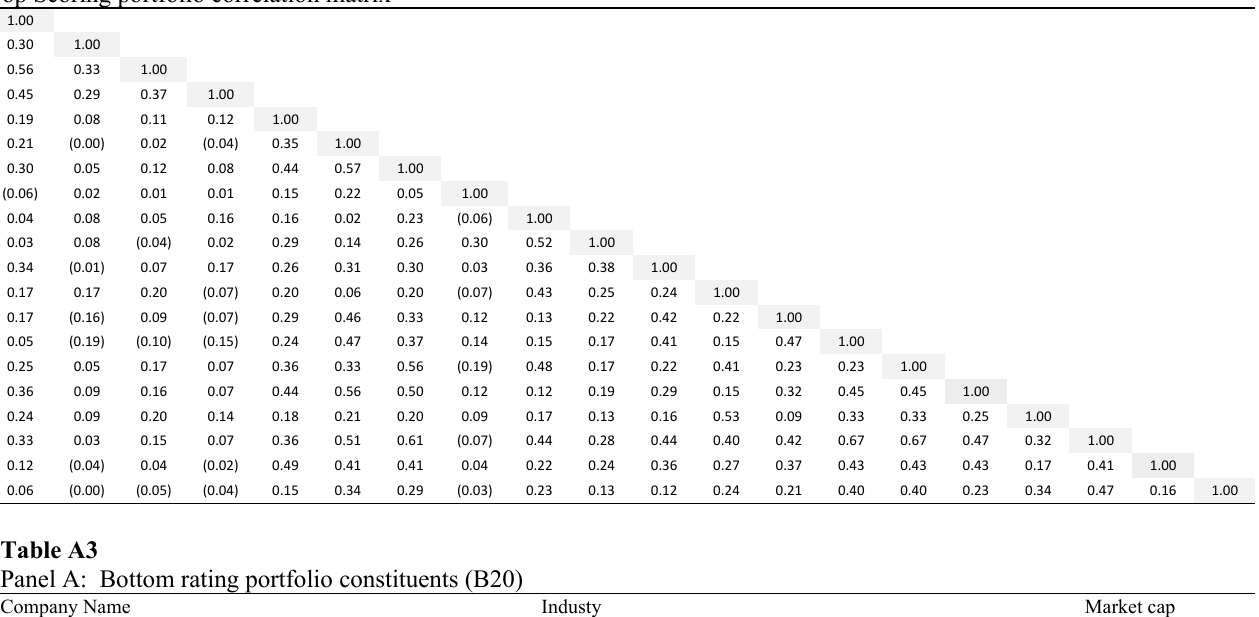
Panel A: Bottom rating portfolio constituents (B20) Company Name Industy Market cap Airasia Group